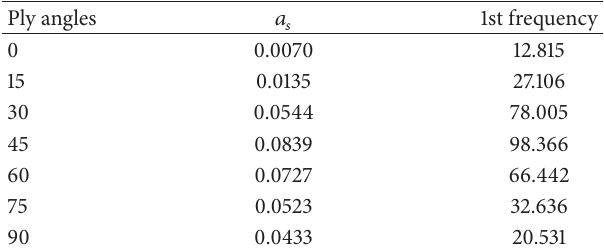
Table 2: The values of 𝑎 𝑠 and 1st frequencies (Hz) versus ply angles ( ∘